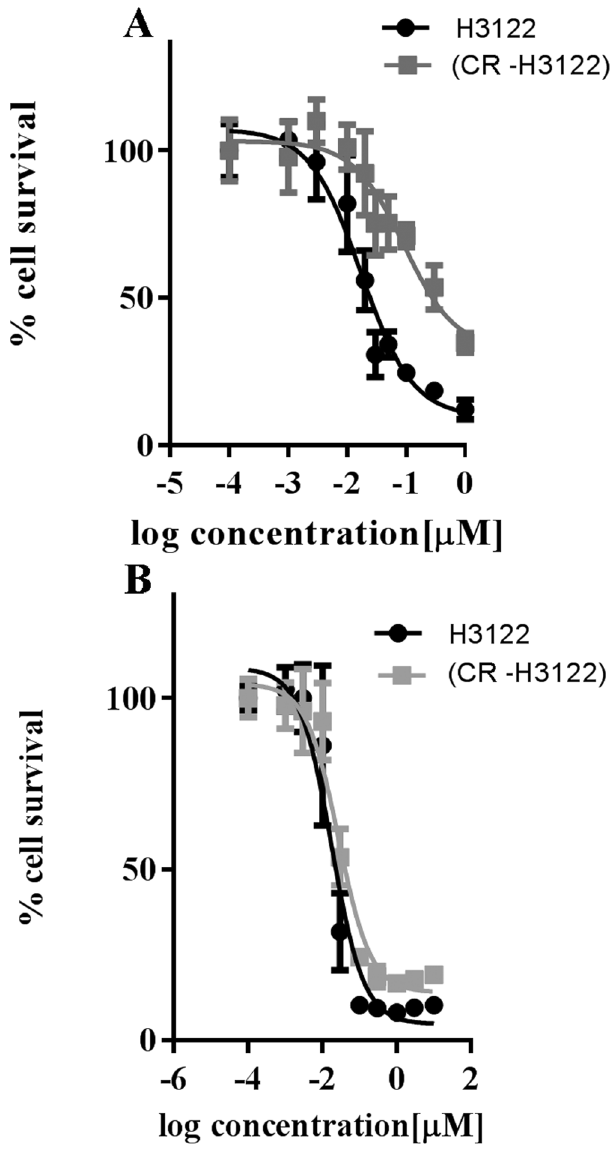
Figure 6. Effect of acquired resistance to crizotinib on cytotoxicity ( A ) Cytoxicity of ceritinib in H3122 and CW-H3122 cells. ( B ) Cytoxicity of AZD3463 in H3122 and CR-H3122 cells. Conventions are as for Fig.